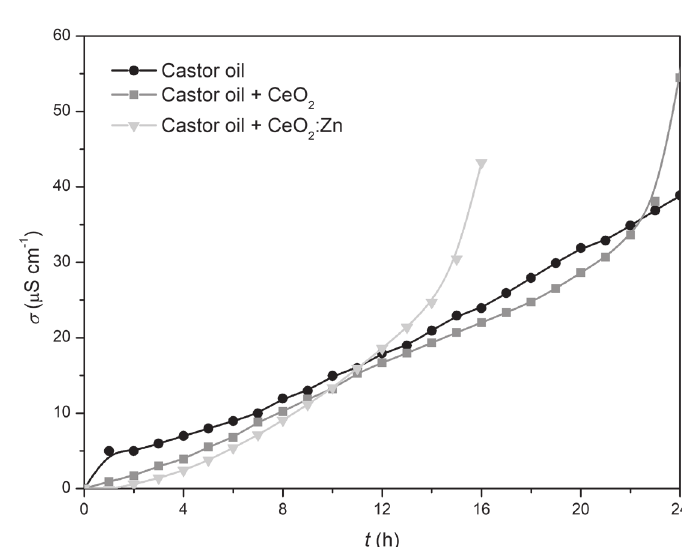
Fig. 5 – Rancimat test results for pure Castor oil, Castor oil with ceria, and Castor oil with zinc-doped ceria